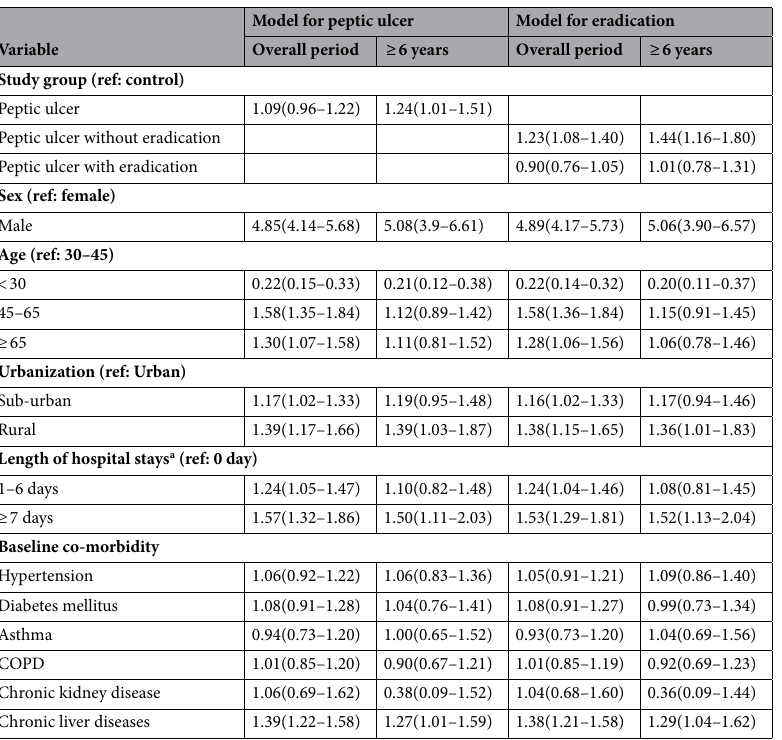
Table 2. Multiple Cox proportional hazard regression for estimation of adjusted hazard ratios on head and neck cancer. COPD, chronic obstructive pulmonary disease. a Length of hospital stays, was the sum of the days in the hospitalization within 2 years before index date.